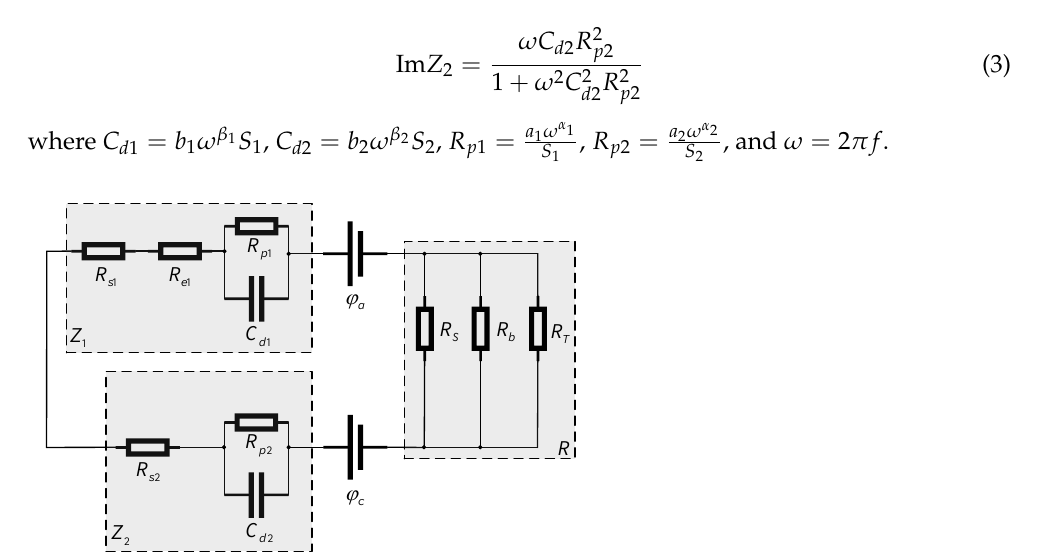
Figure 2. Electric field equivalent circuit of a ship.